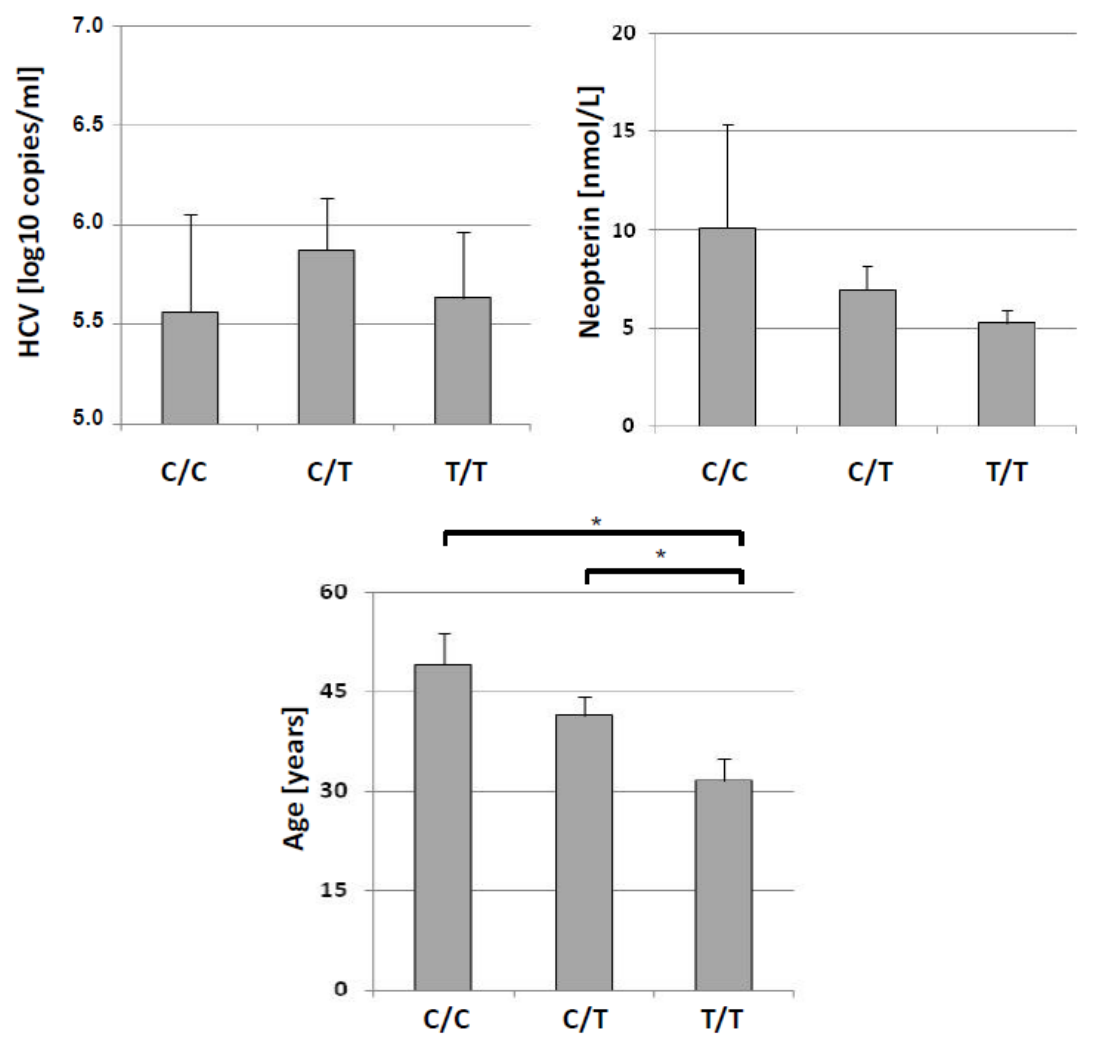
Figure 2. Distribution of HCV load (upper left), neopterin concentrations (upper right) and age in patients (lower) with HCV infection split into three groups according to IL28B genotypes C/C, C/T and T/T (mean + S.E.M. is shown for each genotype, * p < 0.05). Patients with the C/C genotype were older (49.1 ± 13.6 years) than those with C/T (41.4 ± 9.67) or T/T genotype (31.5 ± 7.57; U = 7.044, p < 0.05), and also C/C genotype patients were older than the patients with other than C/C genotype (U = 2.446, p = 0.014). Older age was associated with higher kynurenine concentrations (rs = 0.470, p < 0.05), but there was neither such association of age with KYN/TRP nor (rs = 0.283, n.s.) with neopterin (rs = 0.065,